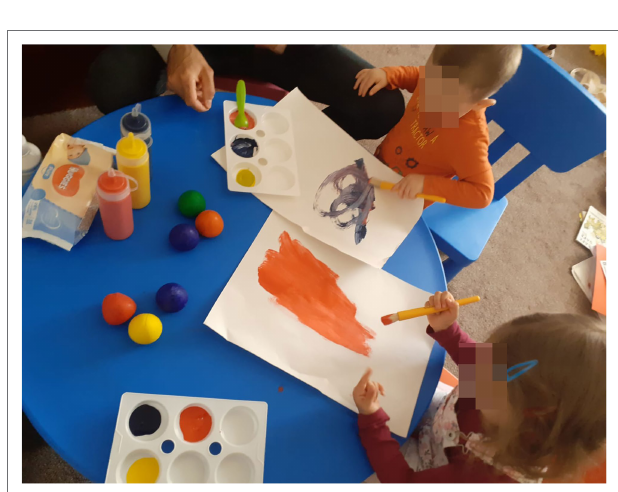
FIGURE 7 | Siblings using the art box together